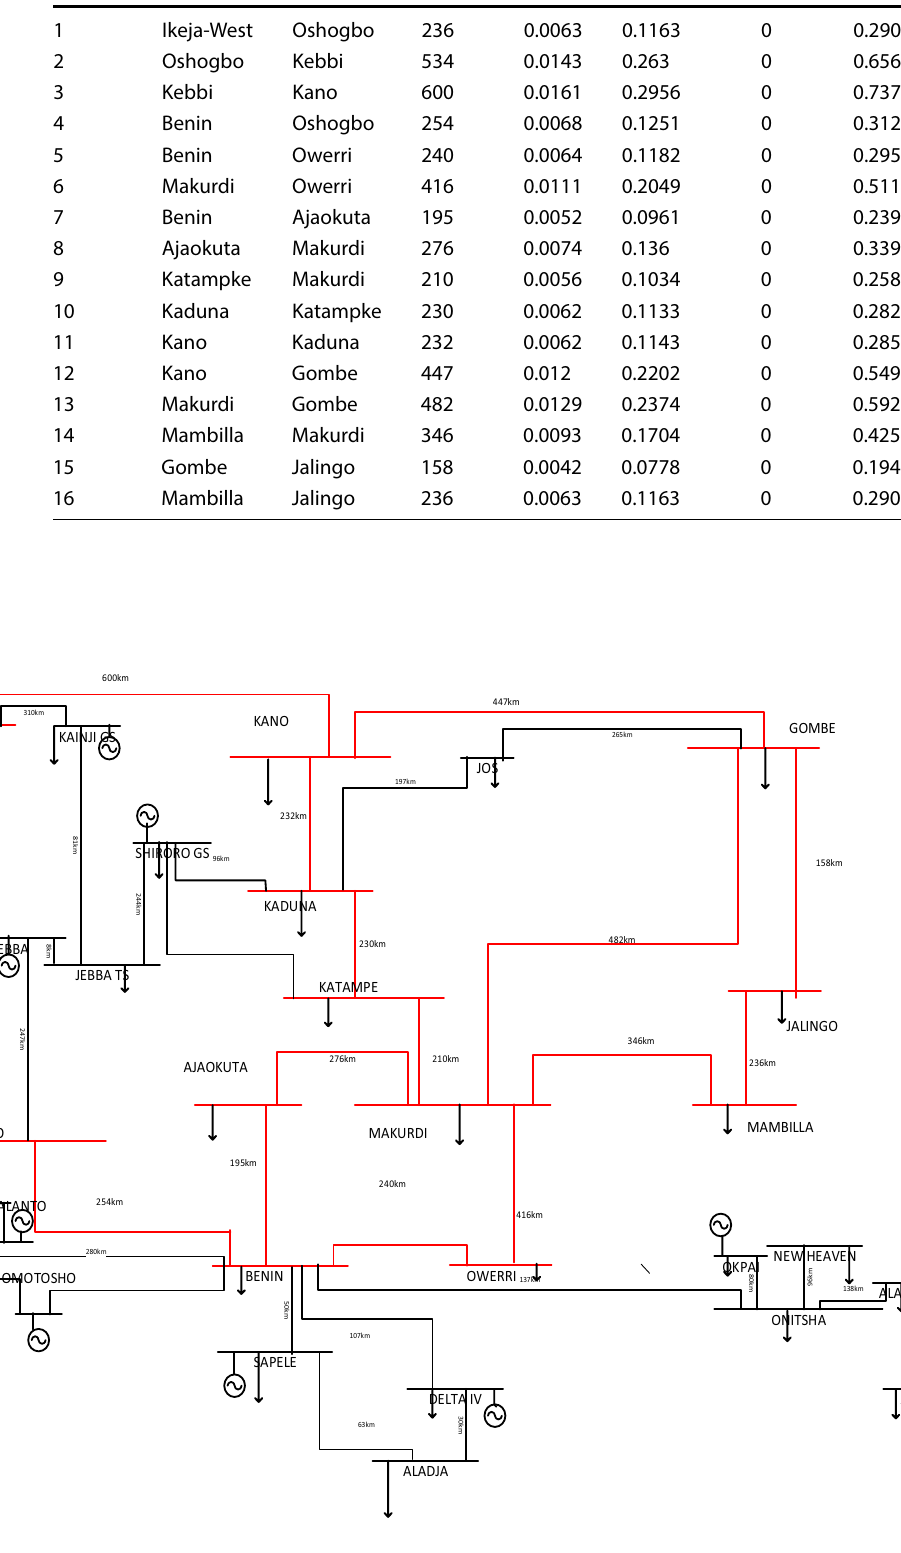
Table 2 Generated transmission line parameters for upgraded 750-kV grid with 1000 KVA base value